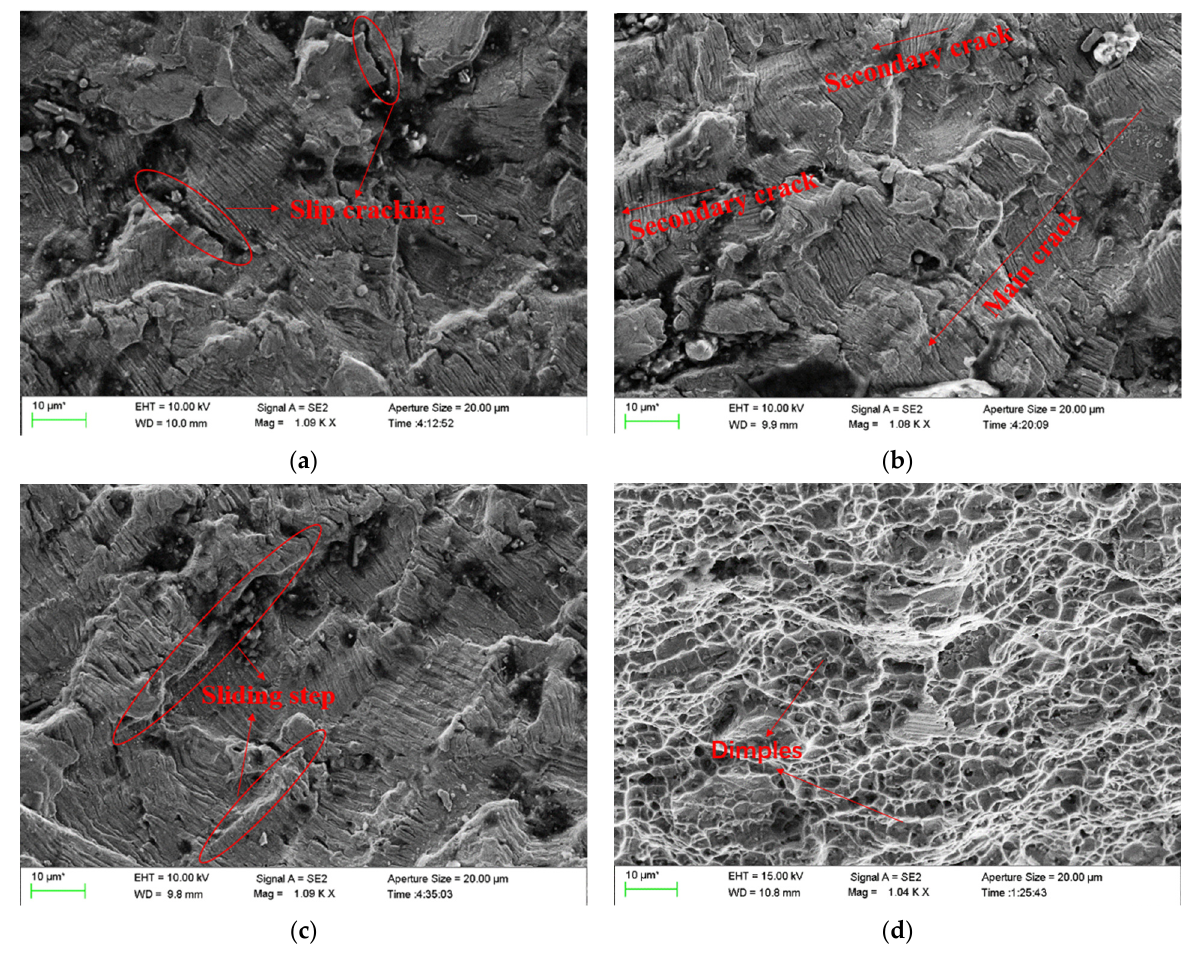
Figure 18. Fracture morphology of the crack in different propagation stages: ( a – c ) correspond to locations 1–3 in Figure 17, respectively, and ( d ) represents the dimple morphology of the instantaneous fracture zone.